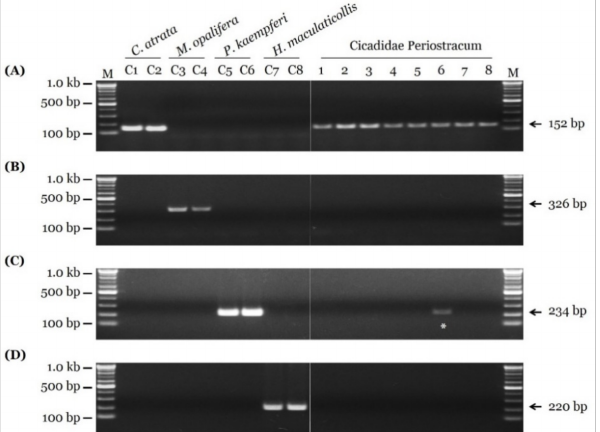
Figure 4. Evaluation of eight market samples using newly developed SCAR markers. Fragments of COI regions of ( A ) C. atrata , ( B ) M. opalifera , ( C ) P. kaempferi , and ( D ) H. maculaticollis were produced using CA_F1 / CA_R1-1, MO_F1-1 / MO_R2, PK_F1-1 / PK_R1, and HM_F1-1 / HM_R1 primer pairs, respectively. Gel images of (left) PCR products of control samples (C1: CA-1, C2: CA-2, C3: MO-1, C4: MO-2, C5: PK-1, C6: PK-2, C7: HM-1, and C8: HM-2) and (right) market CP samples. Asterisk, adulterated sample. Details of market samples presented in Table